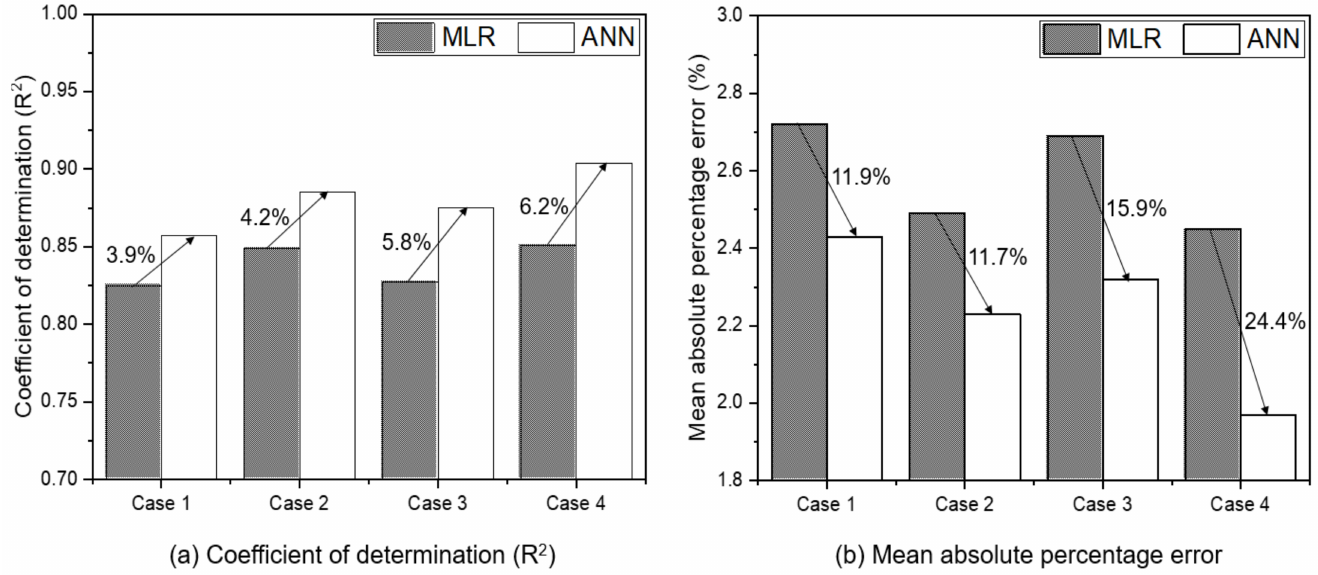
Figure 8. Results of comparison of tractor axle torque estimation performance by MLR- and ANN-based models: Case 1 used engine parameters (ET, ES, and SFC) as input variables. Case 2 used engine parameters and major tractor parameters (TS, TD, and SR) as input variables. Case 3 used engine parameter and soil physical properties (SMC and CI). Case 4 used engine parameters, major tractor parameters, and soil physical